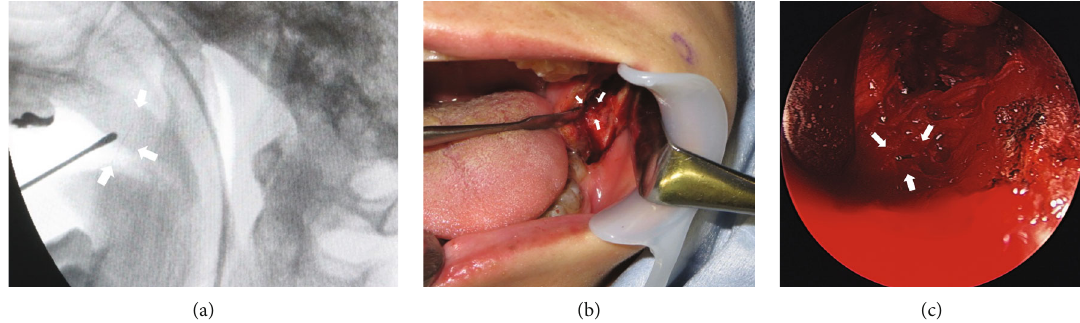
Figure 3: (a) Intraoperative X-ray transmission device images. The position of the broken injection needle was con fi rmed with a sonde using fl uoroscopy. (b) Intraoperative photograph. (c) Endoscopic image taken intraoperatively. An incision approximately 25 mm in length was made on the oblique line of the mandible. A broken injection needle pointing upward from the base of the coronoid process was con fi rmed in the medial pterygoid muscle. Broken injection needles are shown by an arrow.